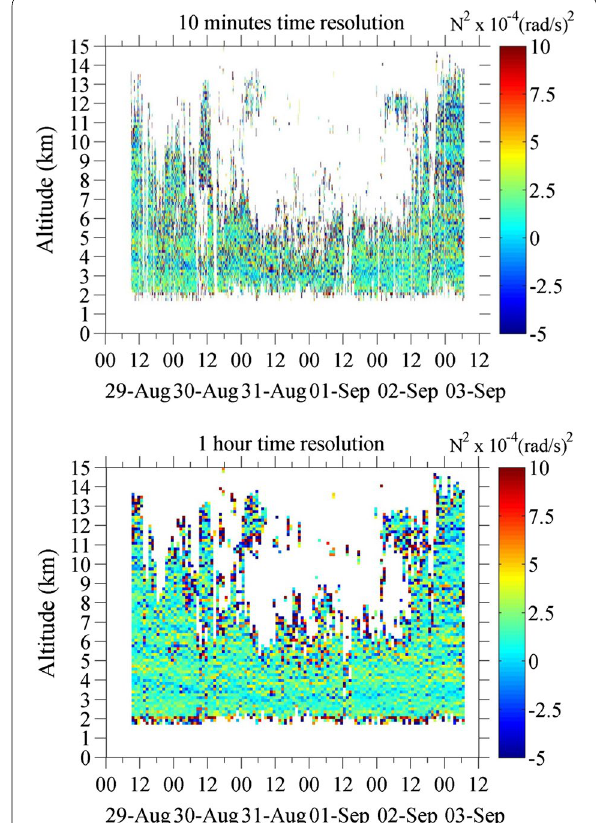
Fig. 17 Time and height variations of N 2 using the T values in Fig. 14 for the averaging of 10 min (top panel) and 1 h (bottom panel), respectively. Arrows in the top panel indicate radiosonde launch tim- ing, where only profiles indicated in black are used for comparison of N 2 with RASS in Fig.